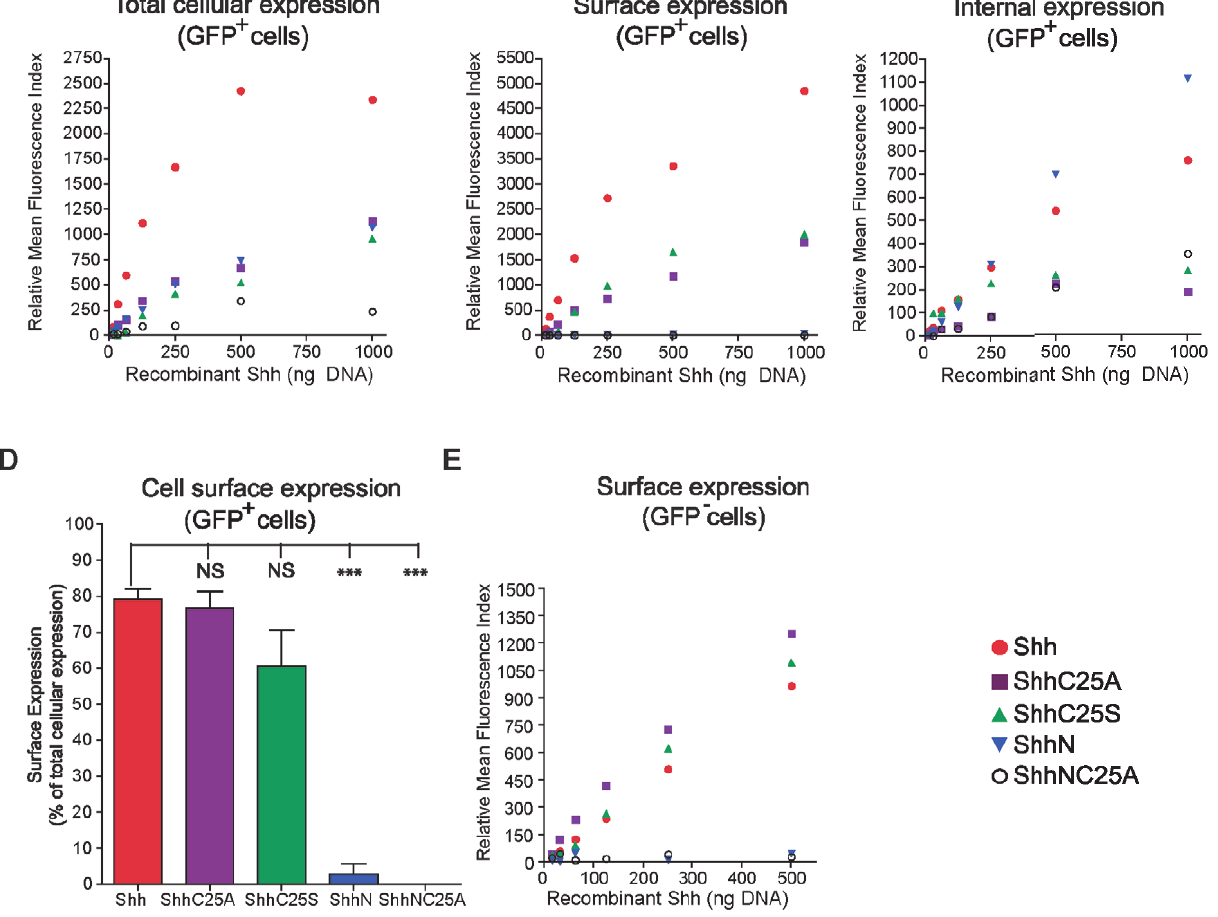
Figure 4. Distinct properties of cholesterol and palmitate modification on cellular localization of Shh ligand. (A–E) Distinct influences of the cholesterol and palmitate modifications on Shh cellular localization were revealed by quantification of mean fluorescence indices (MFI) for 5E1- Alexa 647 staining of NIH3T3 fibroblasts co-transfected with recombinant Shh (0.06 ng to 1000 ng) and EGFP (1050 ng). (A–C) In transfected cells (GFP + ), removal of both lipid adducts greatly diminished total cell MFI (compare ShhNC25A to Shh in A), and abolished surface expression (compare